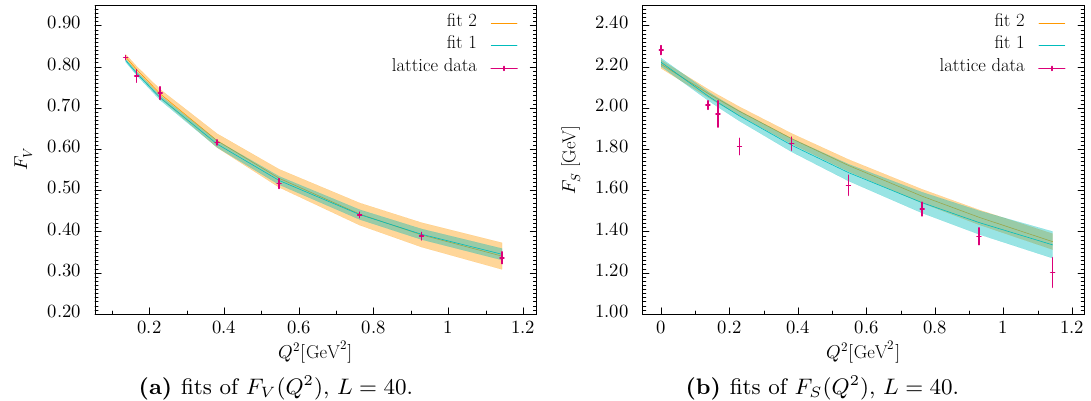
Figure 14. Data for the vector and scalar pion form factors extracted from our simulations, together with the (cid:12)ts speci(cid:12)ed in table 4. F S is given in the MS scheme at scale (cid:22) = 2 GeV.